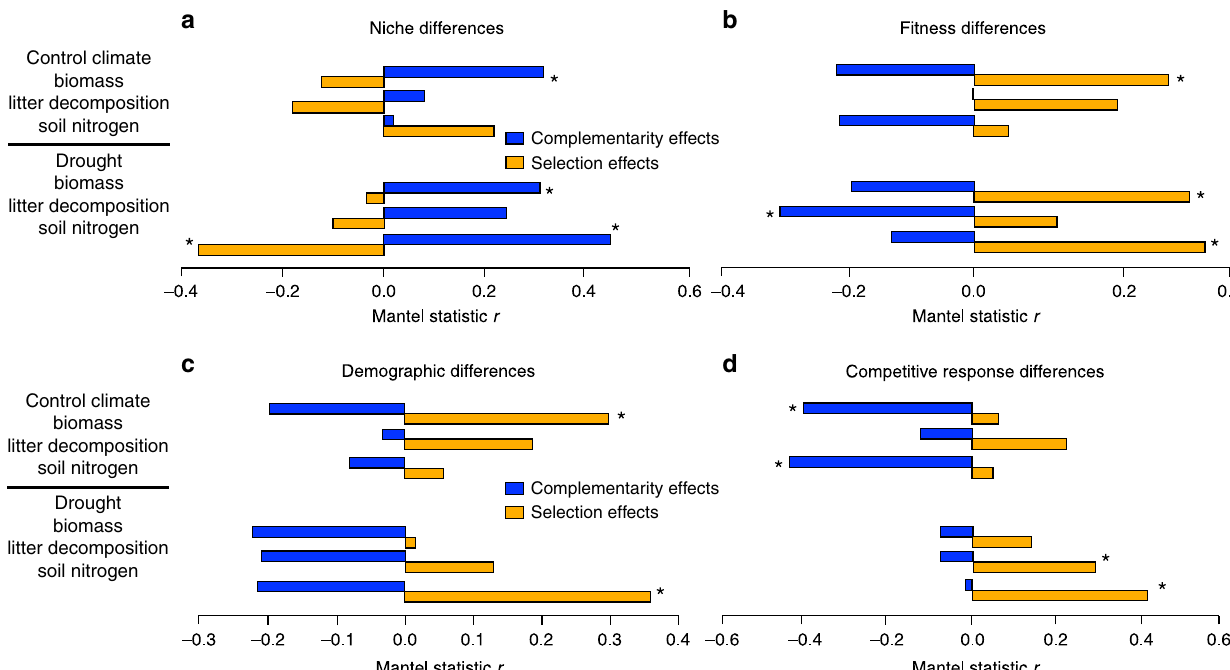
Fig. 2 Correlations between stabilizing niche and average fi tness differences and complementarity and selection effects. Correlations are shown for the three functions considered, under the two contrasting environmental conditions (control climate, drought). Correlations between complementarity (blue) and selection (orange) and niche are fi tness differences are shown in panels a and b . They are also shown with the two components of fi tness differences, the demographic ratio ( c ) and the competitive response ratio ( d ). Signi fi cant correlations following a two-sided test are marked with an asterisk. To assess the degree of statistical signi fi cance while controlling for false discovery rate, we performed Benjamini – Hochberg corrections on raw P values for multiple comparisons ( n = 24 comparisons per species difference